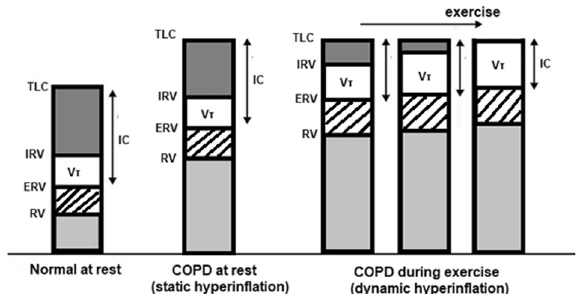
Fig. 1 Pulmonary Volumes during rest and exercise in COPD patients. Figure depicting pulmonary volumes in COPD patients during rest and exercise, representing static and dynamic in fl ation